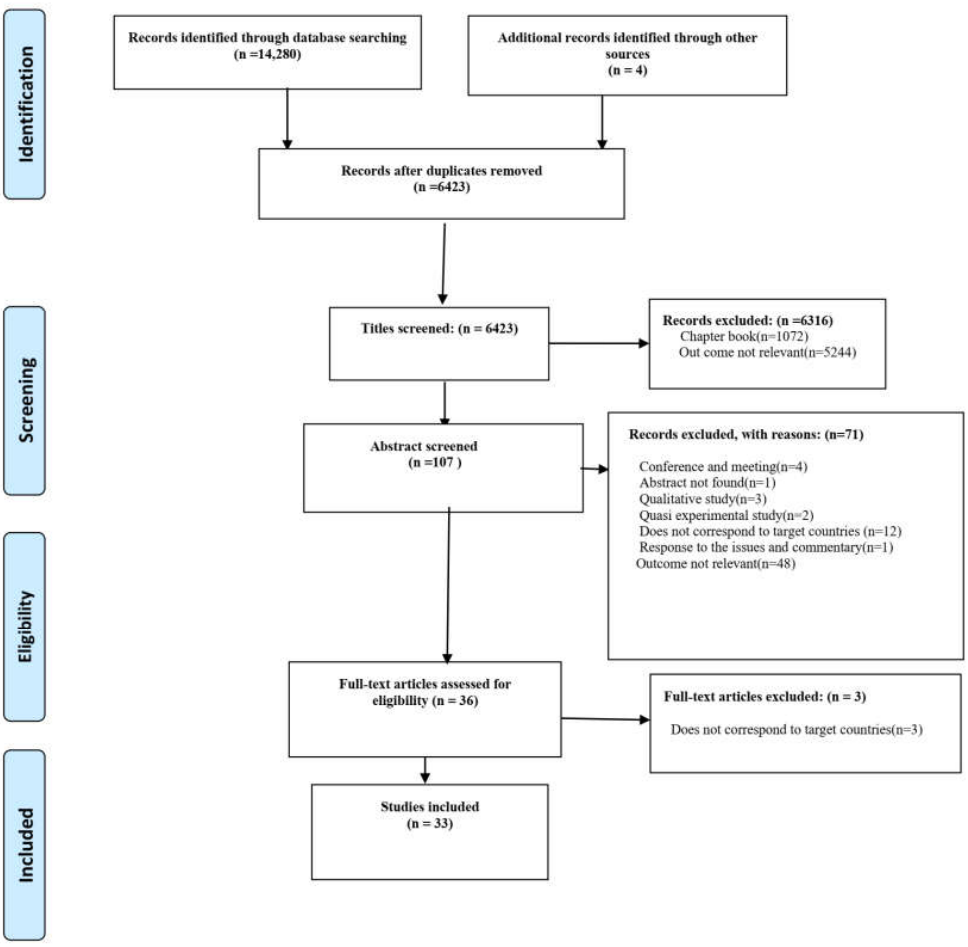
Figure 1. Flow diagram of the process of systematic literature search in accordance with PRISMA guidelines.